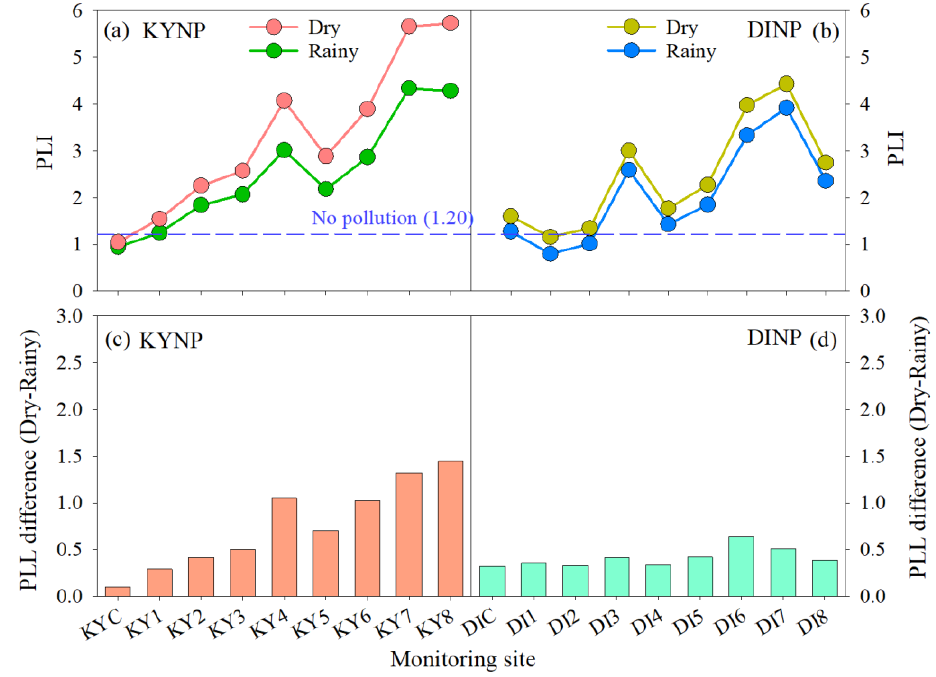
Figure 6. Pollution load index (PLI) at each site during the rainy and dry seasons in Khao Yai National Park (KYNP, a ) and Doi Inthanon National Park (DINP, b ). Difference between the PLI during the rainy and dry seasons at each site in the KYNP (c) and the DINP (d).